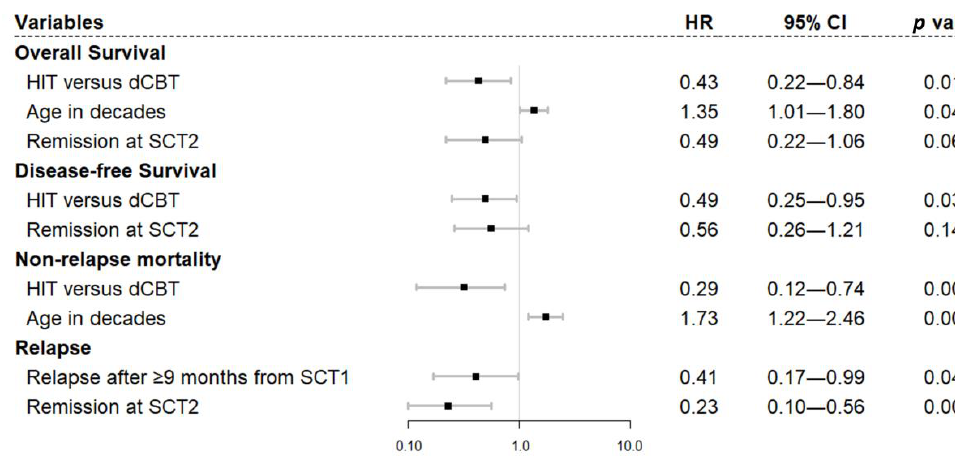
Figure 2. Multivariate analysis of outcomes after second transplantation.